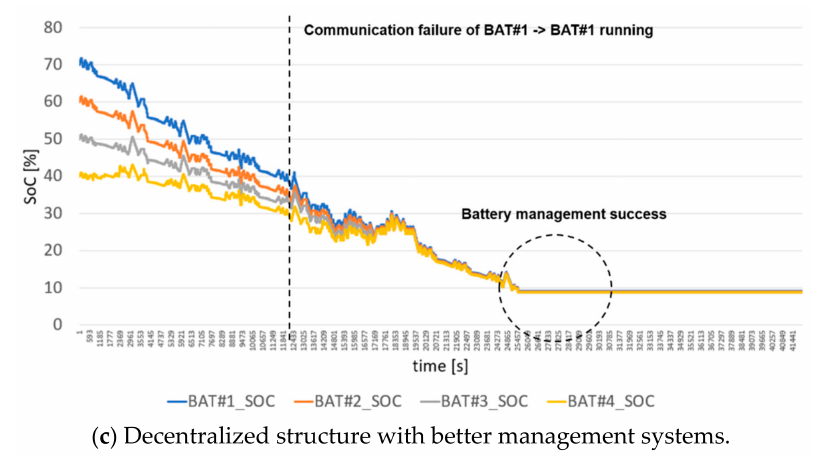
Figure 14. SoC of battery operation under centralized and decentralized